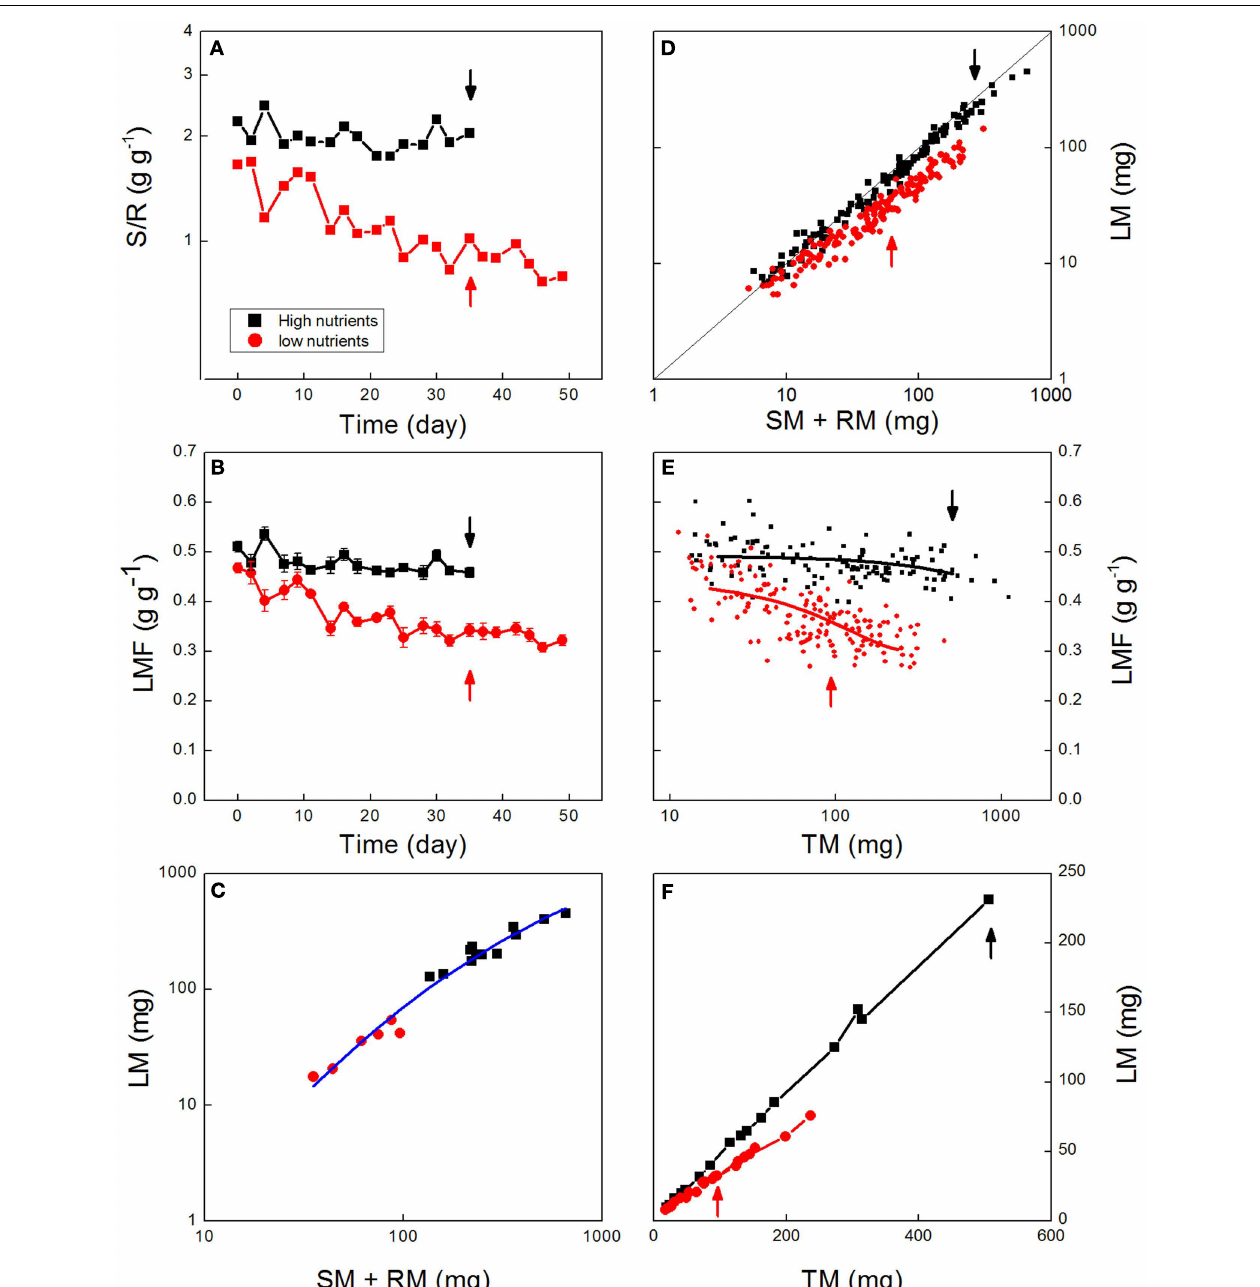
data. (D) Leaf mass plotted against stem plus root mass for all individual plants harvested throughout the experiment.The line indicates the 1:1 relationship. (E) Leaf mass plotted against total plant mass (TM) for low-nutrient and high-nutrient plants. Points represent values for all the individuals harvested during the experiment, and lines show the fitted polynomial trends. (F) Leaf mass plotted against total plant mass throughout the experiment. Points represent averages per harvest. Arrows indicate the plants harvested at day 35. All biomass values are based on dried